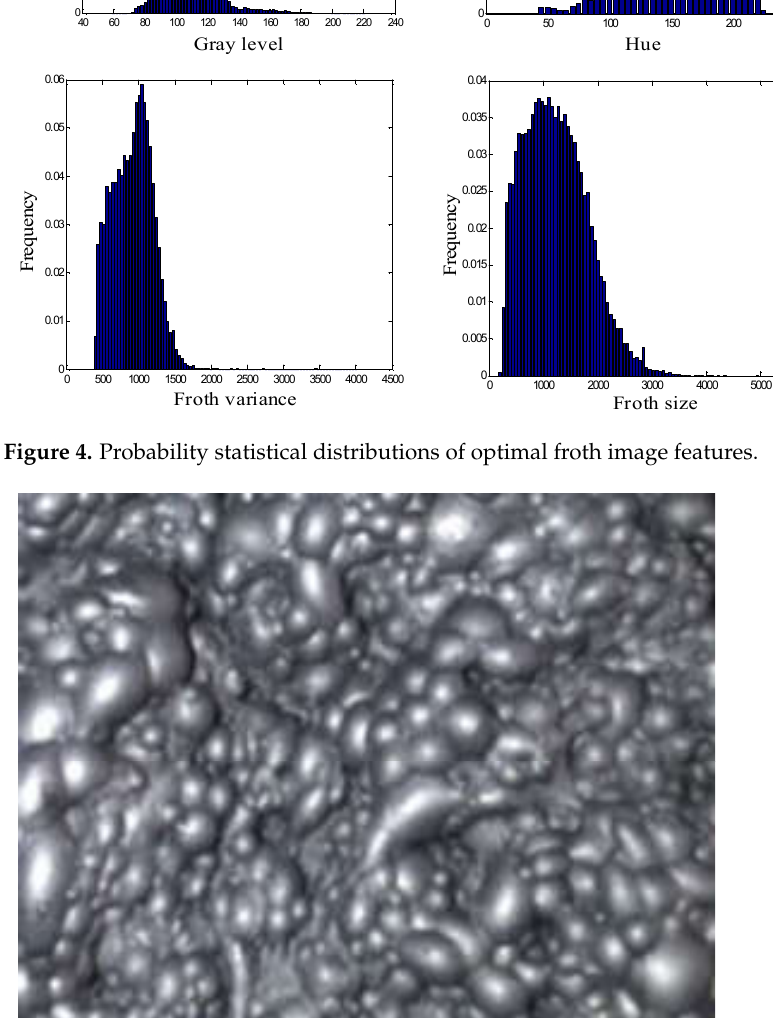
Figure 5. Froth image when the froth features are at the optimal intervals.